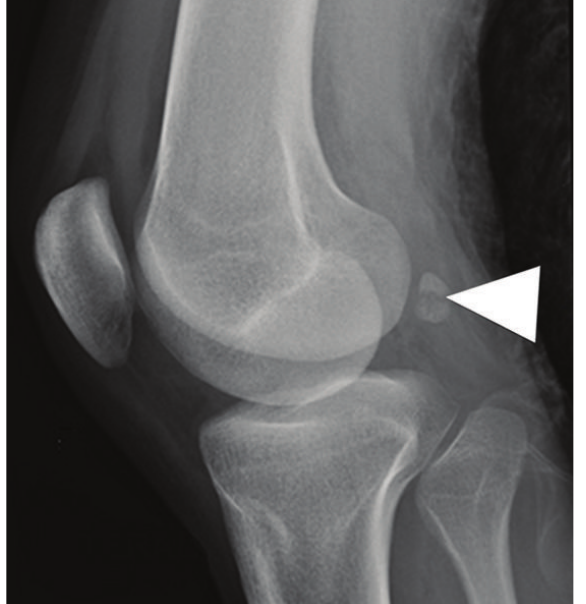
Figure 1: Lateral plain film of the left knee revealed a transverse radiolucent line with irregular borders across an ossified fabella (arrowheads) consistent with a complete fracture of the fabella.